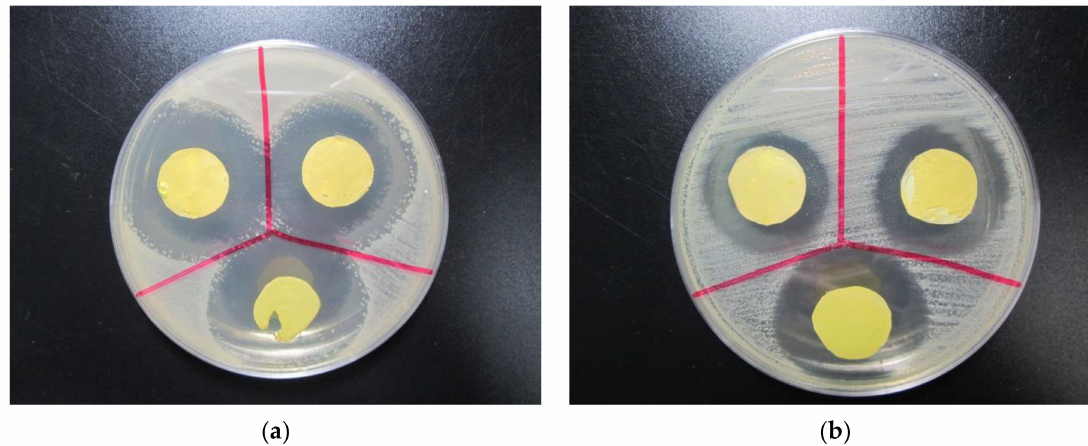
Figure 10. Antibacterial activity of 14% w / v PCL/GE-based nanofiber against ( a ) Bacillus cereus ; ( b ) Escherichia coli . From [118], originally published under a CC-BY